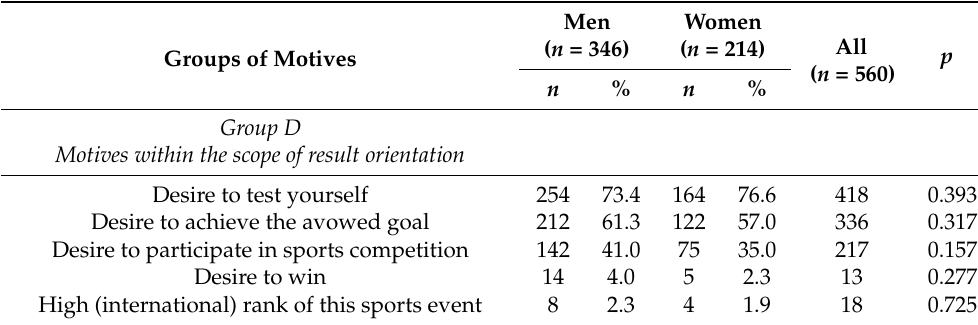
Table 10. Motives within the scope of result orientation.